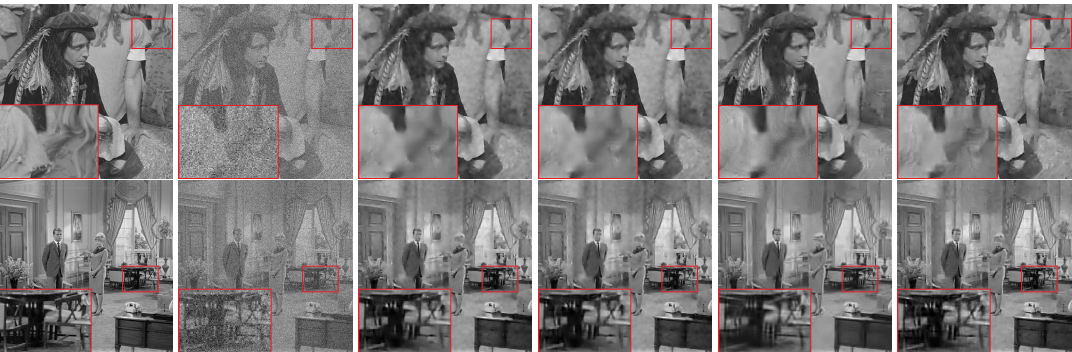
Figure 3. Visual comparison of reconstruction results by different methods on ’Man’ ( σ = 50) and ’Couple’ ( σ = 40). From left to right: original image, noise image, KSVD [9], method of [1], method of [21] and our proposed method. Table 2. PSNR (dB) for nature image denoising